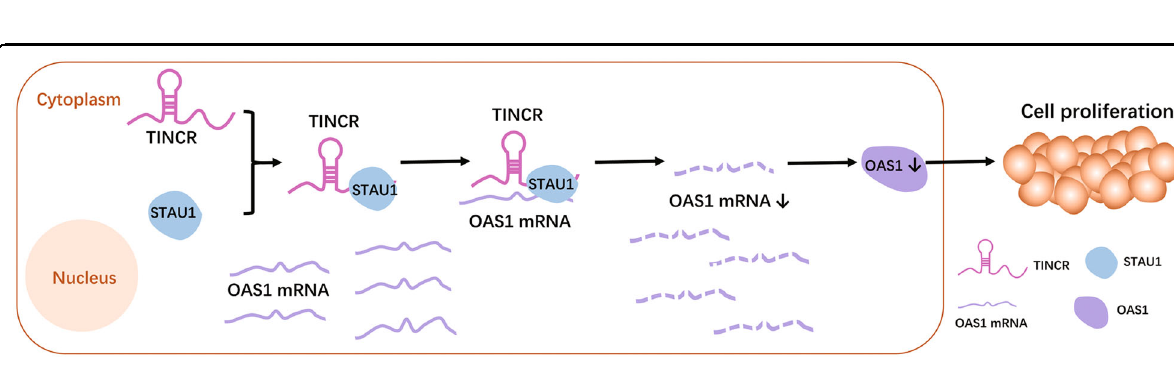
Fig. 8 Summary diagram describes that TINCR regulates breast cancer cell proliferation. TINCR-STAU1-OAS1 axis in breast